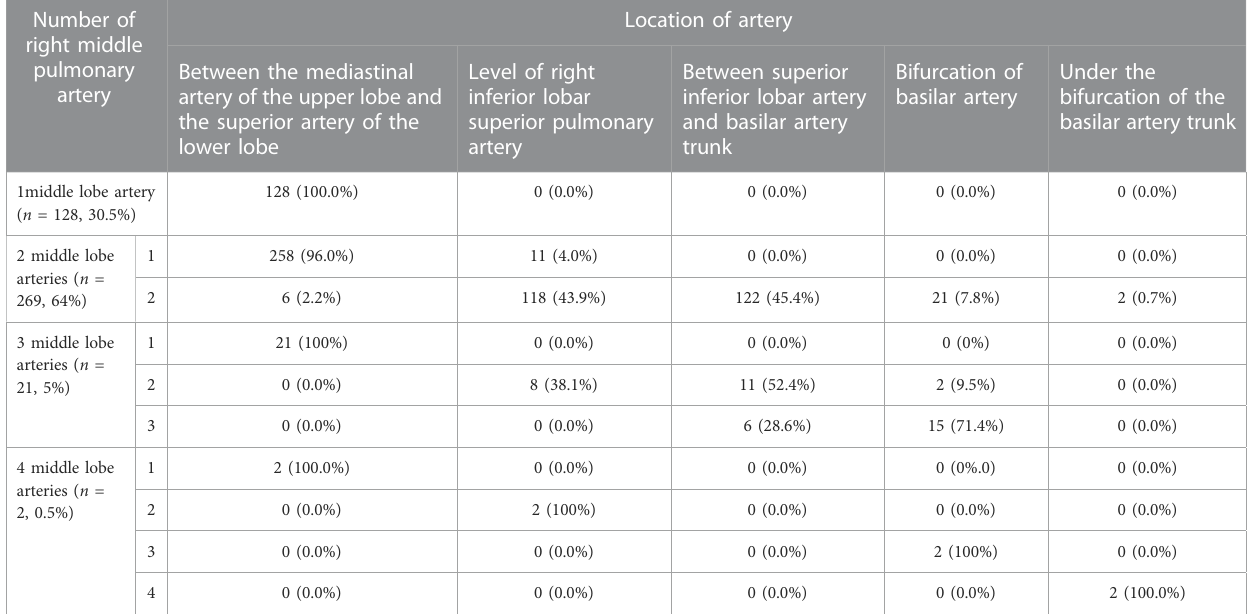
TABLE 5 Variation of right superior lobar pulmonary artery.